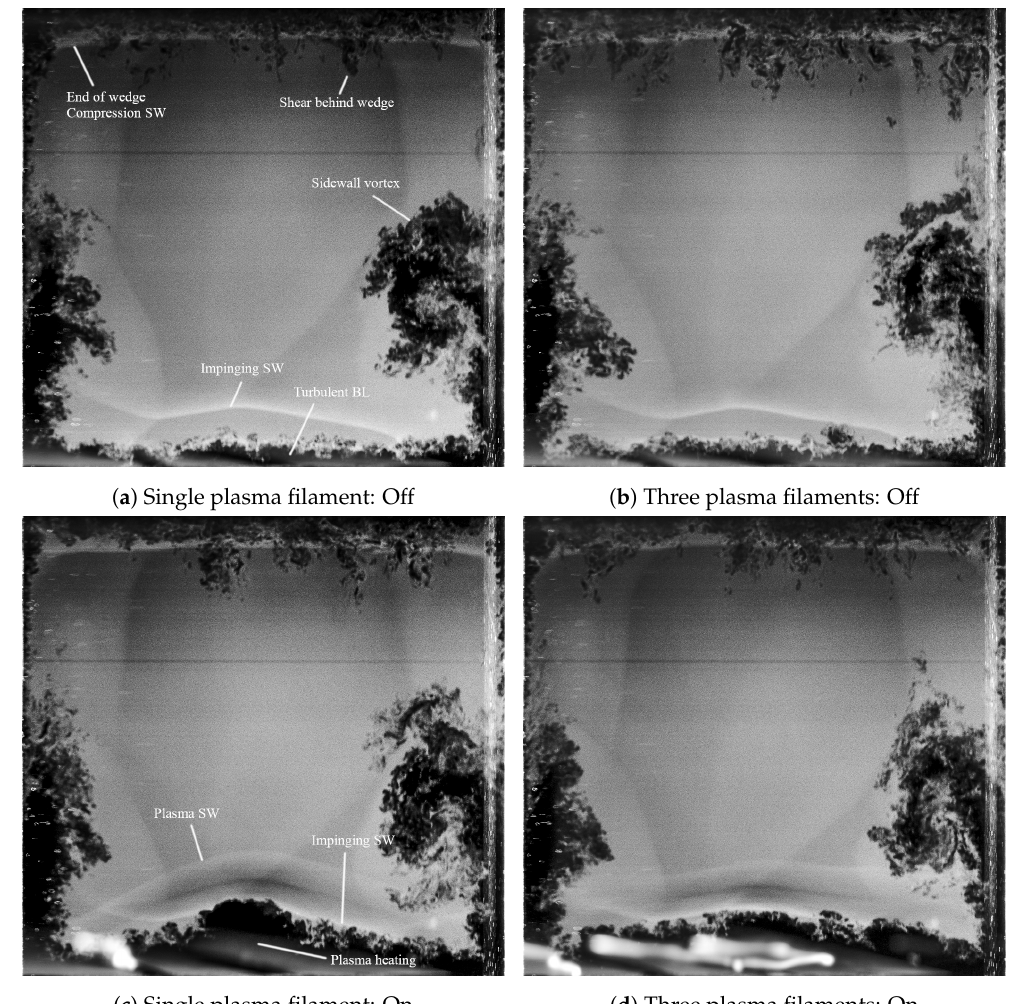
Figure 9. Mie scattering visualization of crossflow features during a plasma pulse.